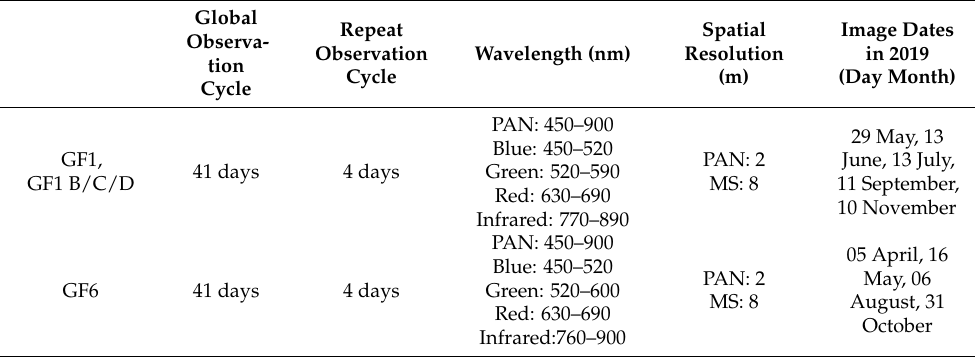
Table 1. Specifications for GaoFen-1 (GF1) and GaoFen-6 (GF6) satellites.